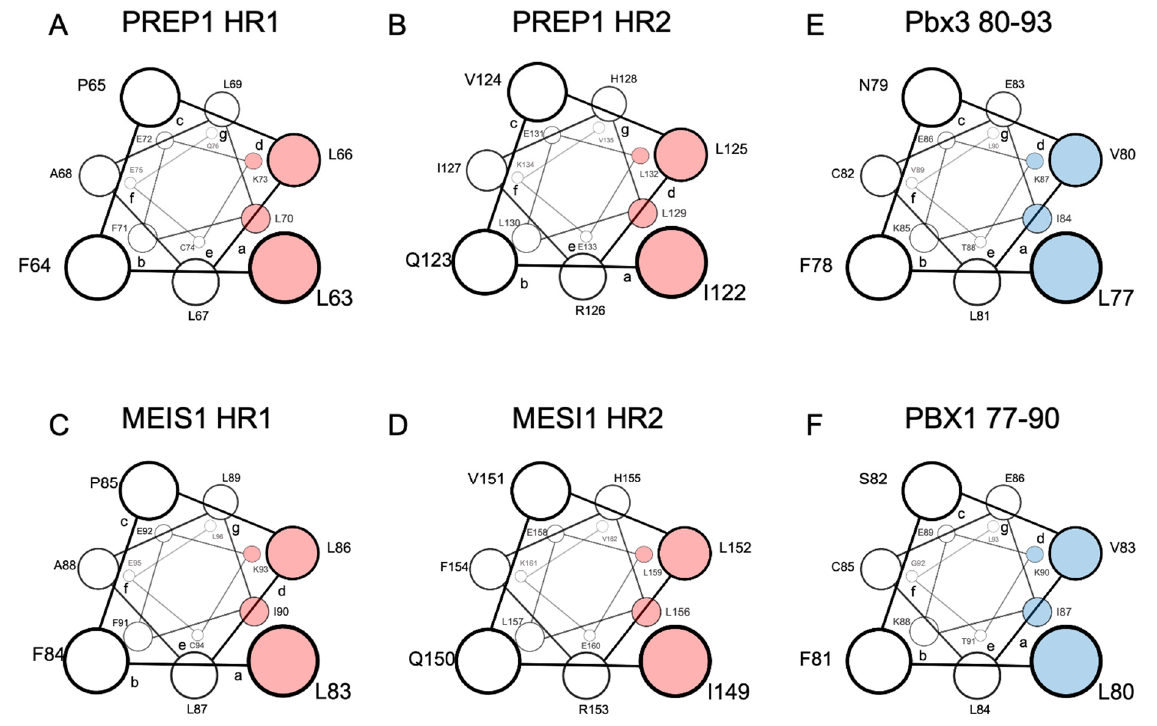
Figure 1. Schematic representation in a top view perspective of the alpha-helices of PREP1 and MEIS1 involved in the leucine zipper with PBX1. For MEIS1 and PREP1, the residues in positions “a” and “d” of the alpha helix, crucial for the interaction with PBX1, are highlighted in red for Pbx3 and PBX1; the important residues for binding MEIS1 and PREP1 are highlighted in blue. Panel ( A ): PREP1 HR1; panel ( B ): PREP1 HR2; panel ( C ): Meis1 HR1; panel ( D ): Meis1 HR2; panel ( E ): Pbx3 80-93; panel ( F ): PBX1 77-90. HR stands for “Homology Region”.